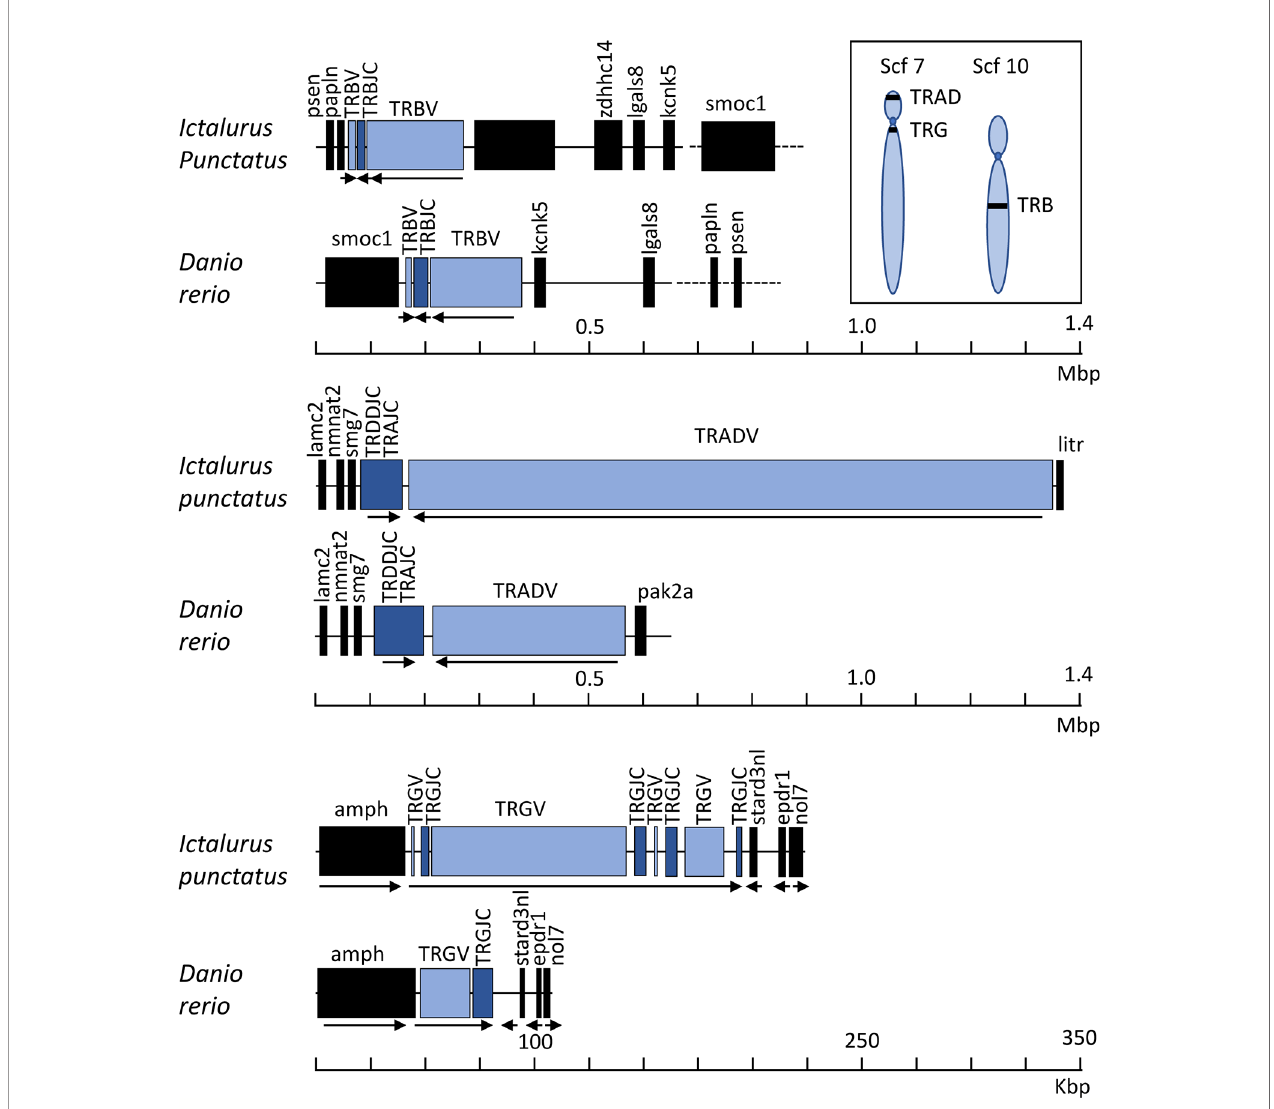
FIGURE 9 | Germline representation of the channel cat fi sh TRB, TRAD and TRG loci. Schematic arrays of the cat fi sh TRB, TRAD, and TRG loci are shown compared with those of the zebra fi sh, Danio rerio . TRV gene segments are in blue, TRC constant region genes are in navy, and non-TR fl anking genes are in black. Arrows show the direction of transcription within each of the TR arrays. Note that the scale bar for the TRB and TRAD loci span 1.4 Mbp, while the scale bar for the TRG loci spans 350 kb. A schematic of the approximate chromosomal locations of the cat fi sh TR loci are at the upper right. In the cat fi sh CCBL1 genome assembly, the TRAD and TRG loci are located on scaffold 7 and the TRB locus is present on scaffold 10. Zebra fi sh annotations were based on accession numbers: TRB: NC_007128.7; TRG: LR812064; TRAD: NC_007113.7. Schematics are drawn to